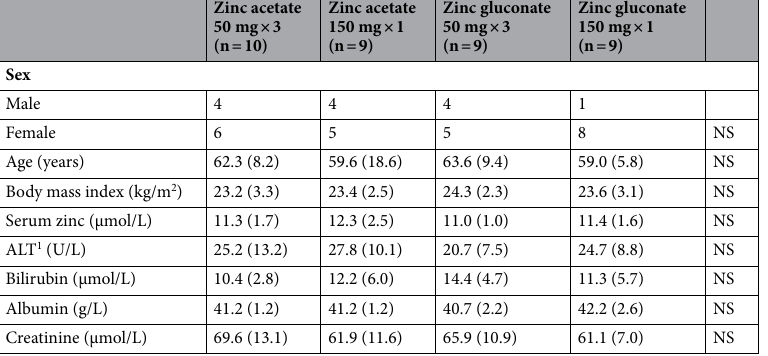
Table 1. Patient characteristics with selected blood samples. NS non-significant ( P > 0.05). 1 Alanine